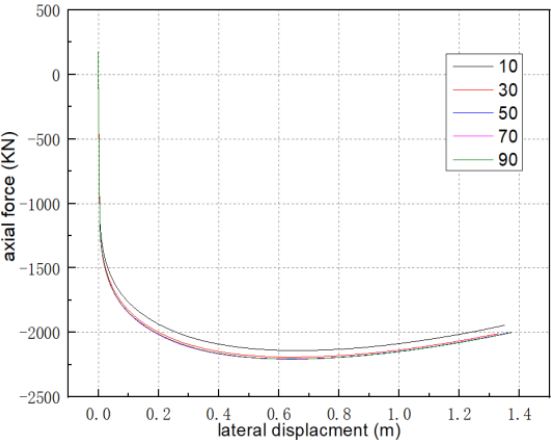
Figure 10. Influence of buoyancy unit interval in the axial force – lateral displacement graph. Table 8. Critical axial force of buoyancy unit interval.